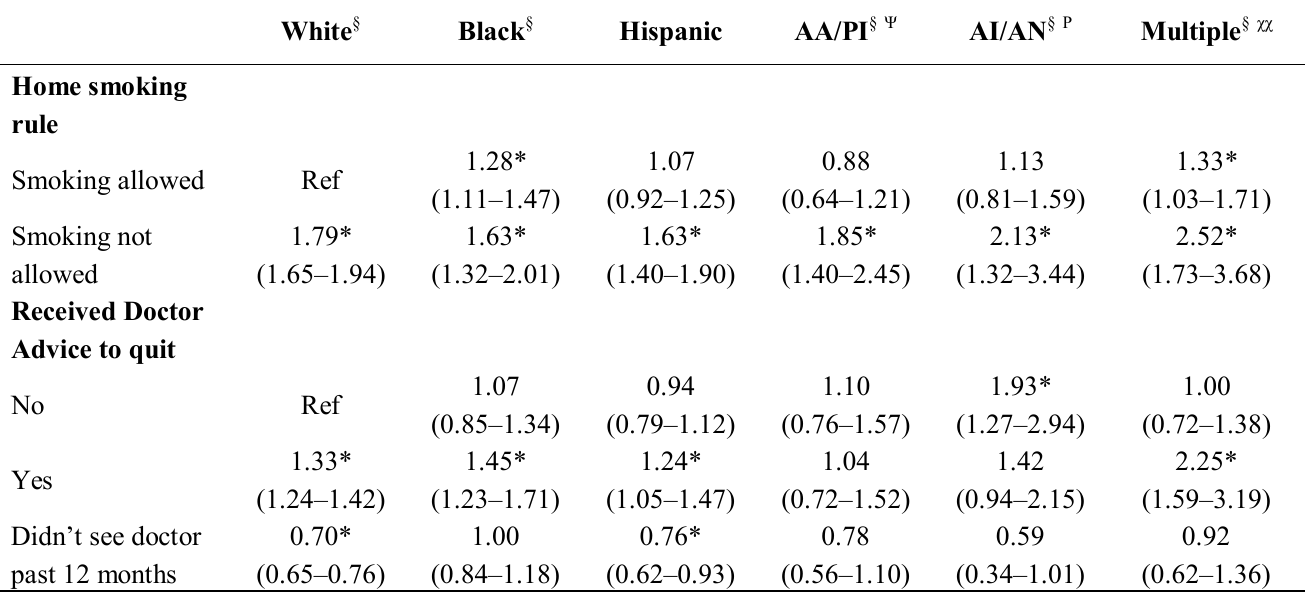
Table 4. Adjusted odds ratios for statistically significant interactions with race/ethnicity from multivariate logistic regression model Ж for having a quit attempt in the past year among